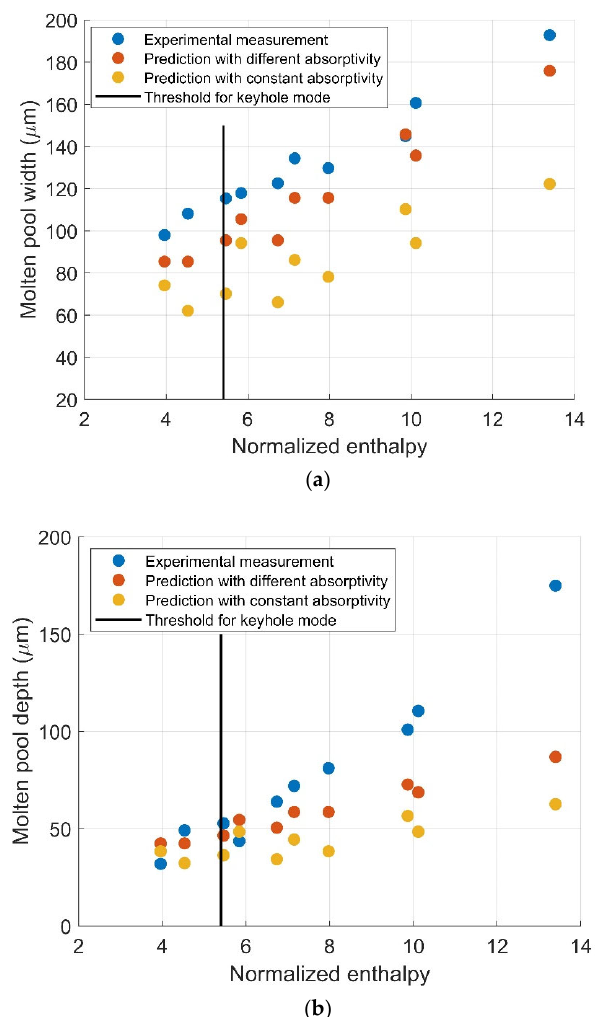
Figure 3. Sensitivity of molten pool size to normalized enthalpy. ( a ): Molten pool width. ( b ): Molten pool depth.